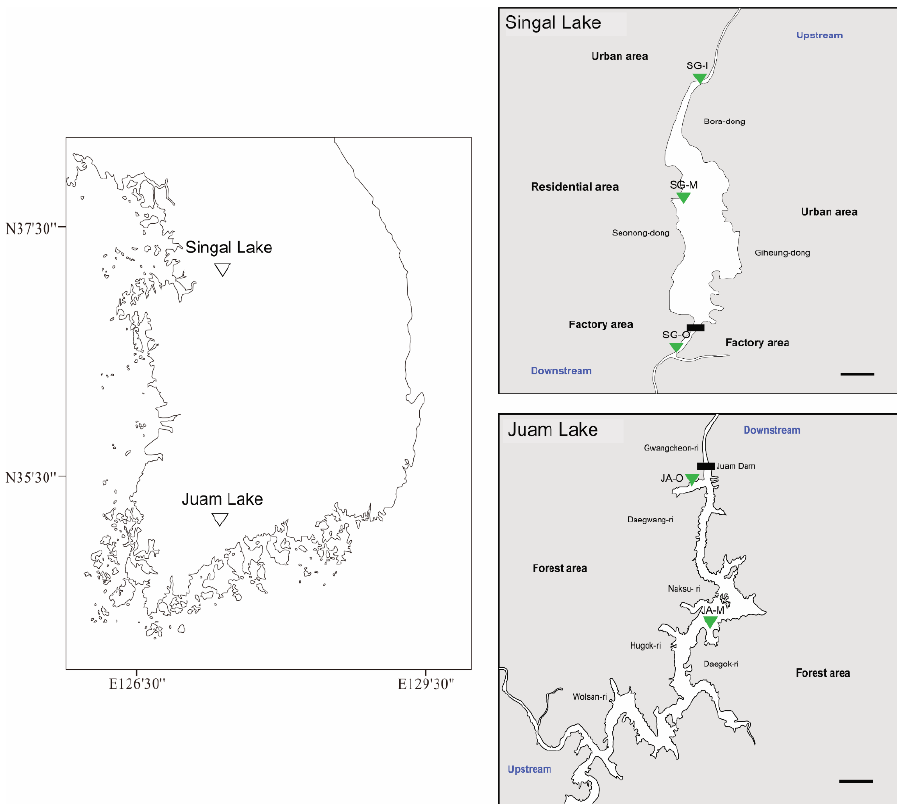
Figure 1. Location of the study area and sampling sites (Black line: 1 km) .